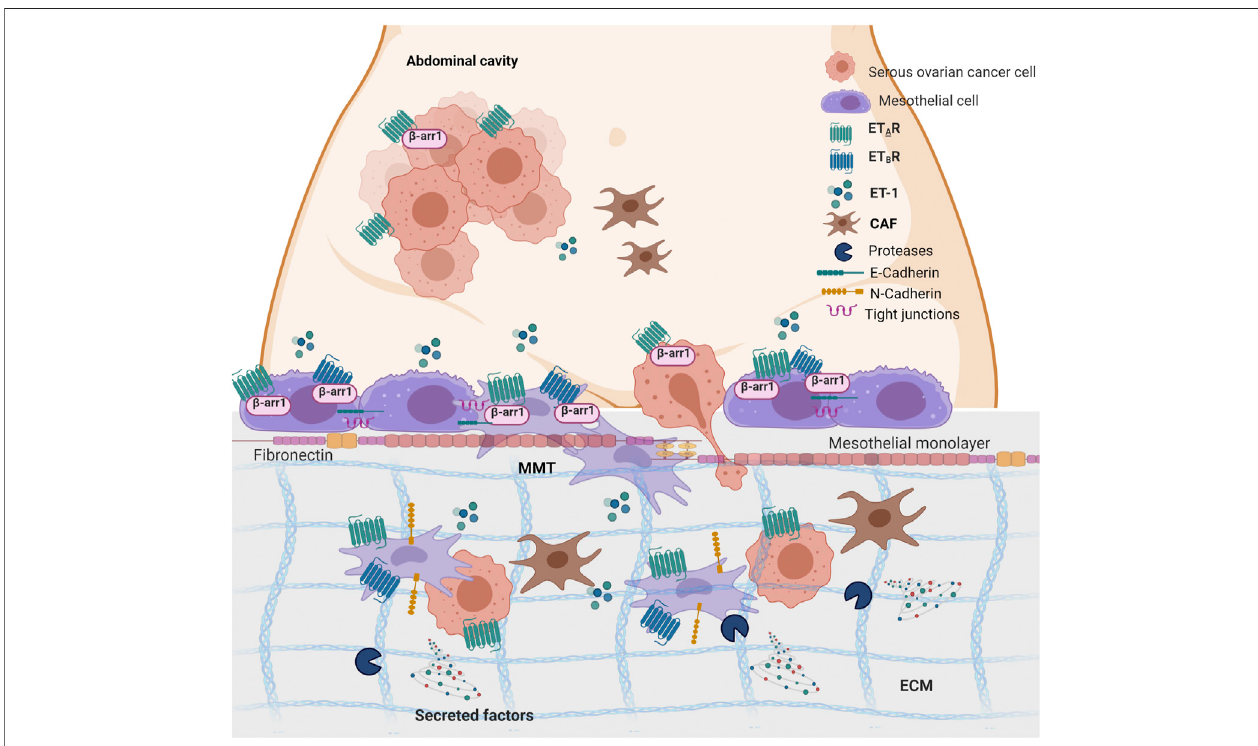
FIGURE 10 | ET-1 promotes mesothelial to mesenchymal transition (MMT) through ET A R/ET B R/ β -arr1 axis. The working model describes the crosstalk between MCs and SOC cells. Autocrine and paracrine ET-1 activates ET A R and ET B R in mesothelial cells leading to MMT, migration and invasion and favouring transmesothelial migration of SOC cells. Created with